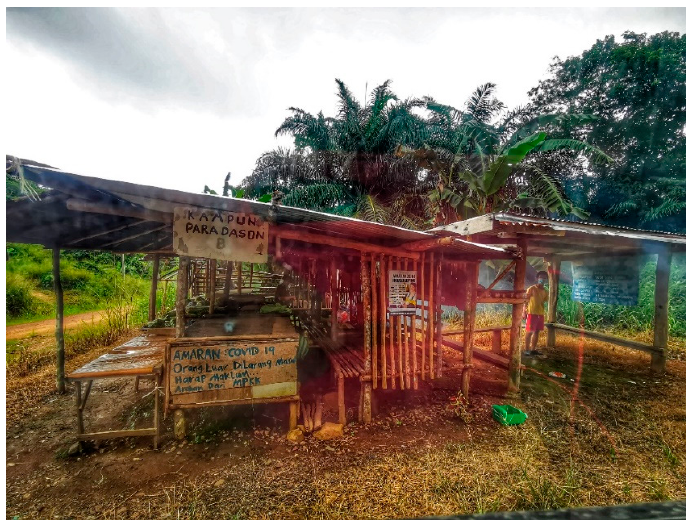
Figure 3. “No entry to outsiders” sign in the Malay language outside the village.